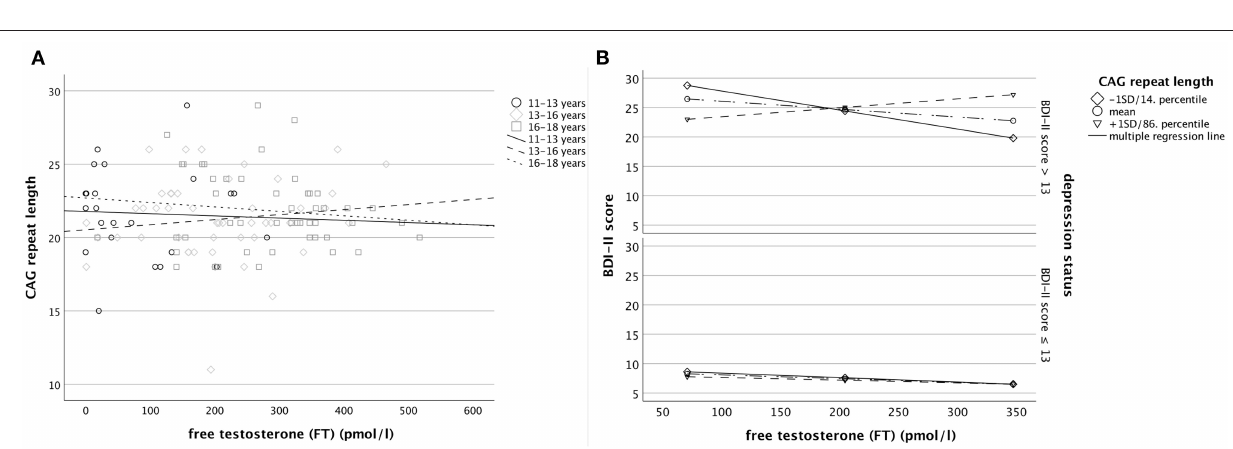
FIGURE 2 | Separately for patients with a BDI-II score > and ≤ 13, (A) the bivariate correlation between free testosterone and the CAG repeat length (left panel) by 3 different age groups and (B) regression lines derived from the Johnson-Neyman analysis regarding the linear relationship between free testosterone levels and BDI-II scores individually plotted for exemplary groups of CAG-length [at − 1 SD (14. percentile), the mean, and + 1 SD (86. percentile); right panel], considering multiple covariates according to model